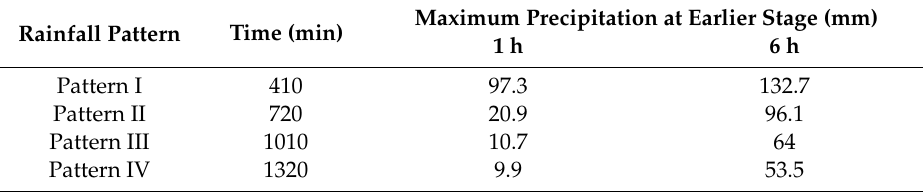
Table 3. The rainfall threshold at the time of critical discharge on C-C’.